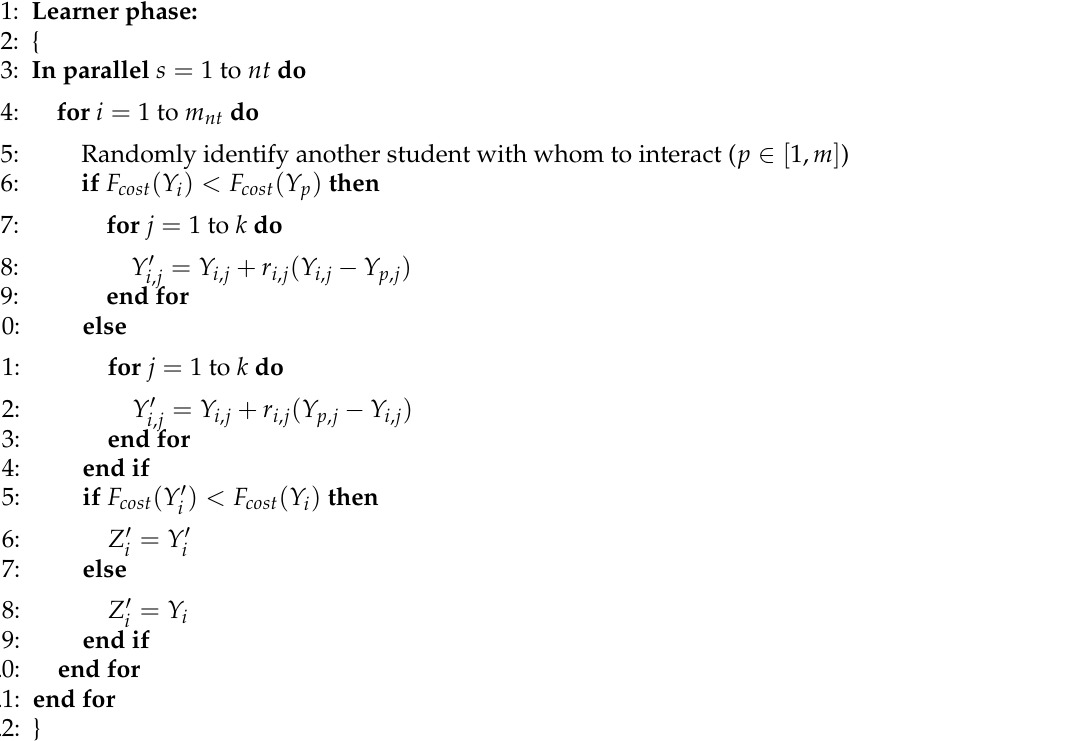
Algorithm 5 Learner phase of SPG_TLBO algorithm.